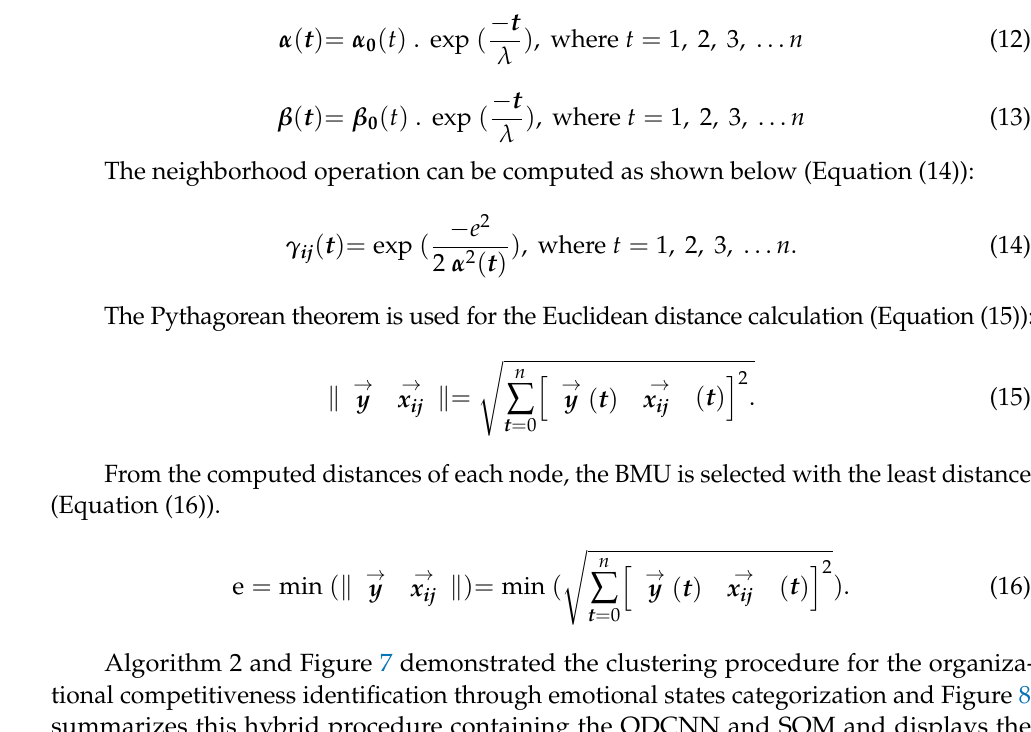
Figure 7. Organizational competitiveness using a self-organizing